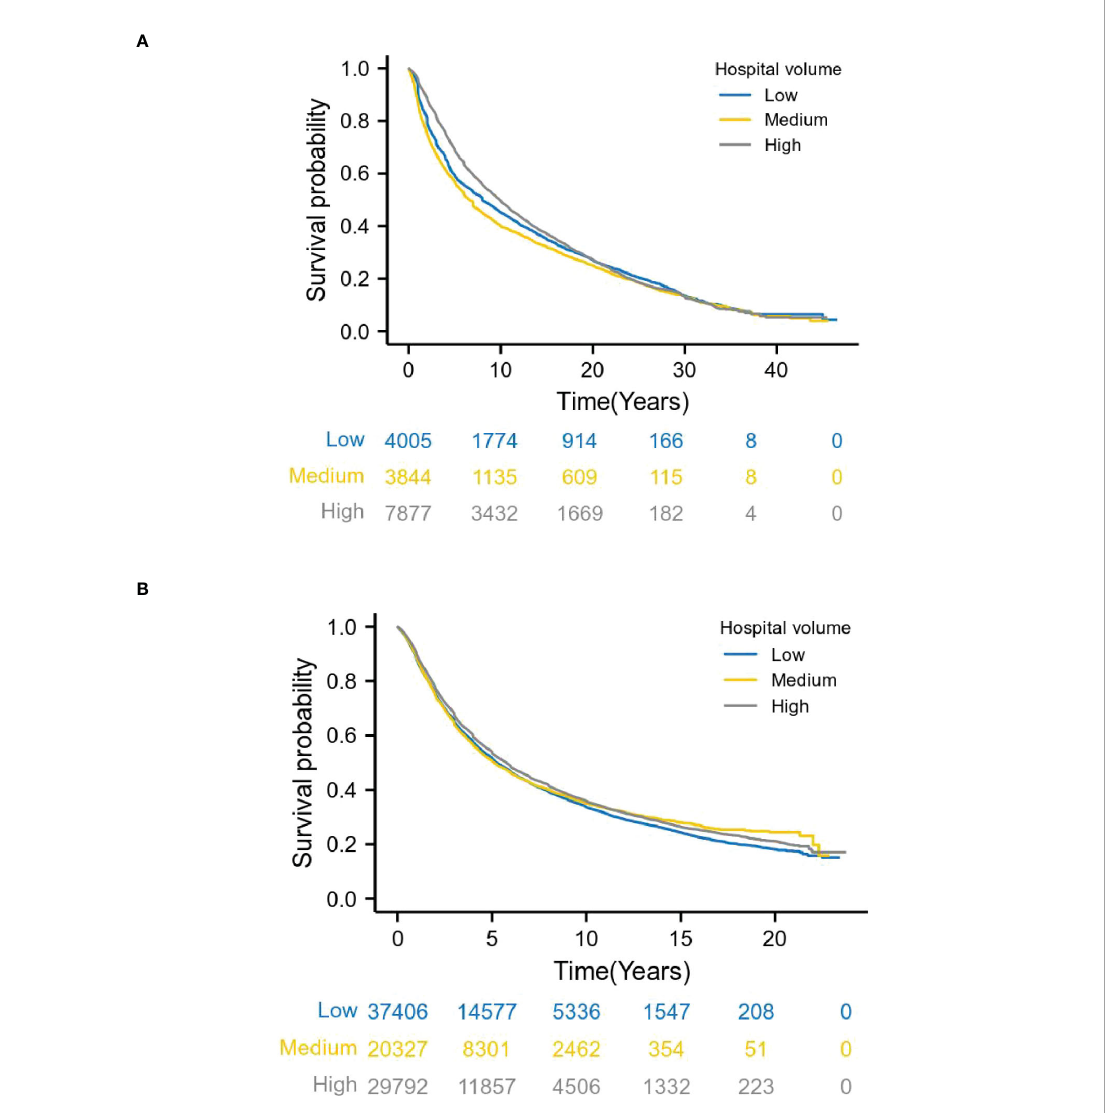
FIGURE 3 Relationship between hospital volume and overall survival by year. (A) shows patients with esophageal cancer from 1973 to 1996, and (B) from 1997 to 2020. Long-term survival analysis, Kaplan-Meier curve showed that patients with stage I-III esophageal cancer who underwent surgery in high volume hospitals had better survival than patients in low volume hospitals (log-rank P